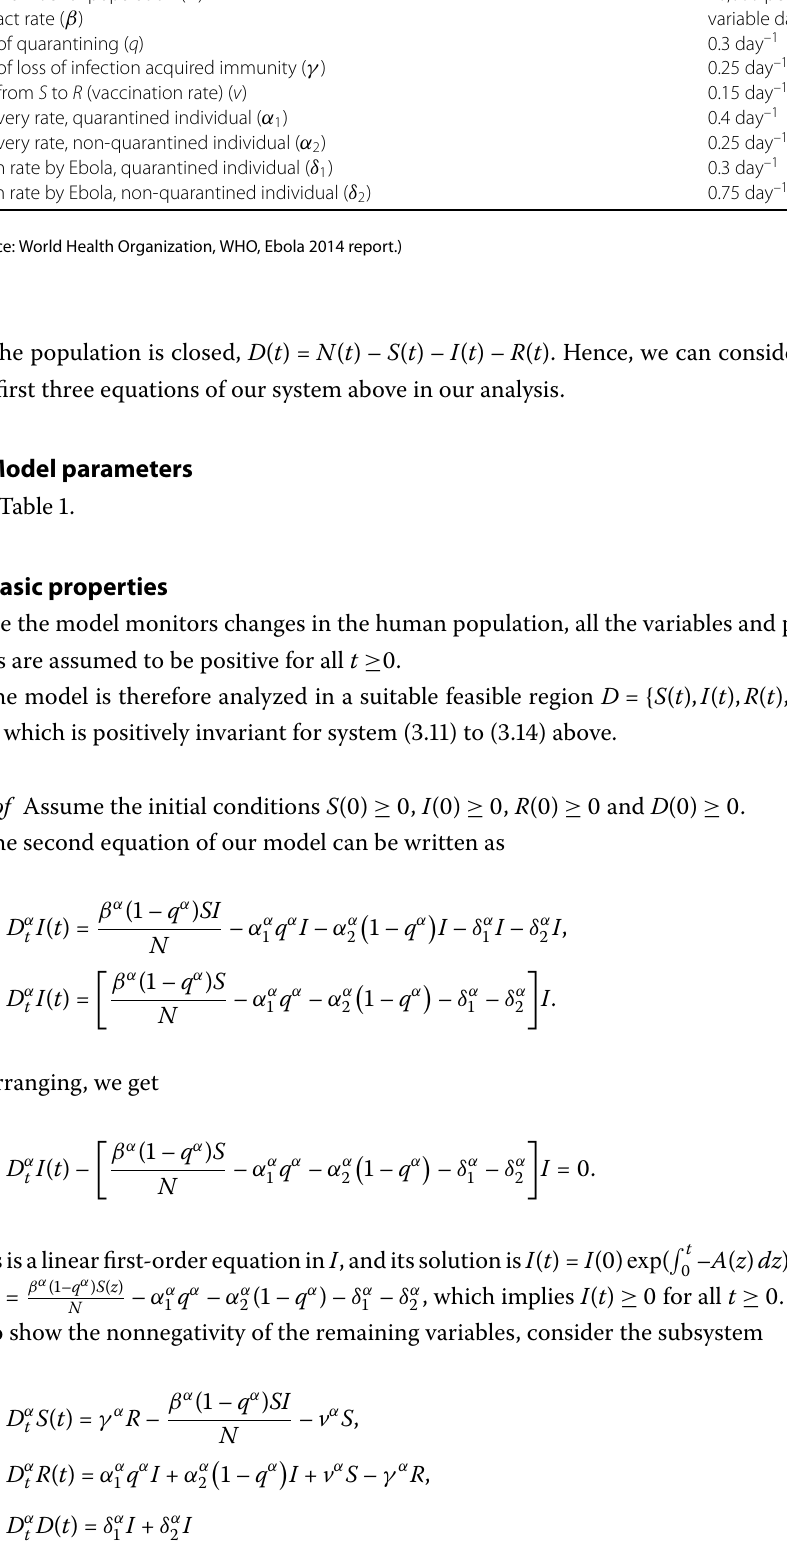
Table 1 Model parameters for simulation Parameter Average value Total number of population